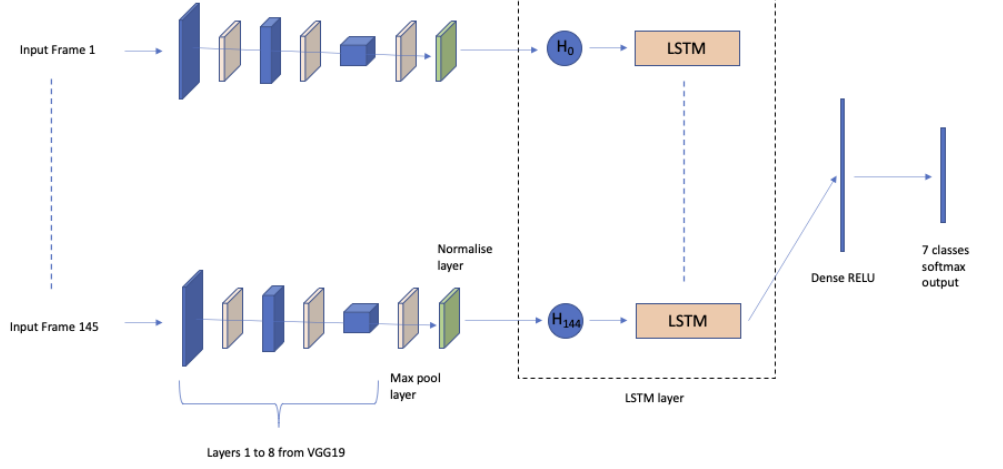
Figure 5. Normal or abnormal movement classification by means of VGG for feature extraction and LSTM for temporal modelling as proposed in [66].